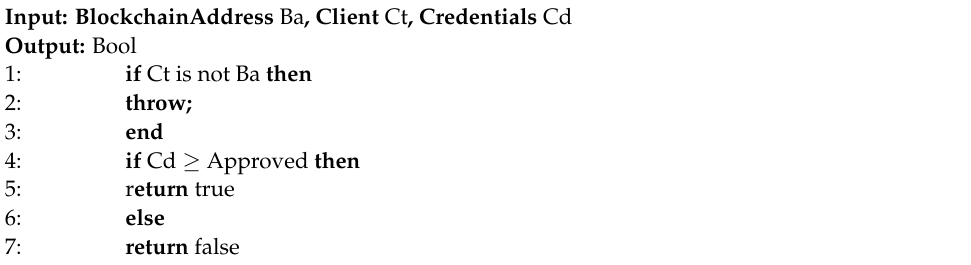
Algorithm 2: Access_Request: Algorithm shows how a client access its data on